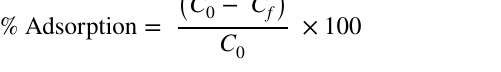
Table 3 Physical characteristics of water samples